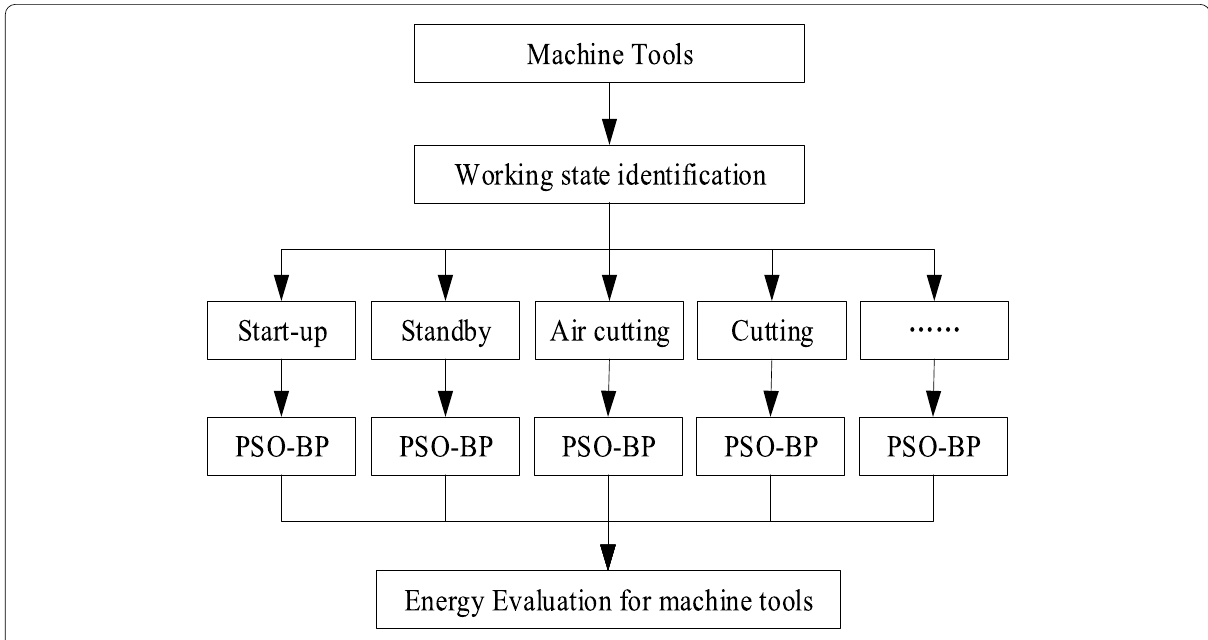
Figure 7 Energy evaluation for machine